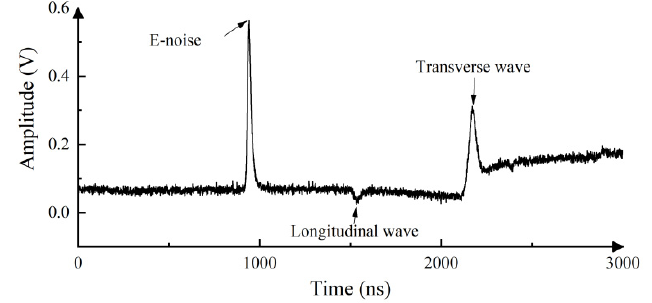
Figure 7. Laser ultrasonic experimental